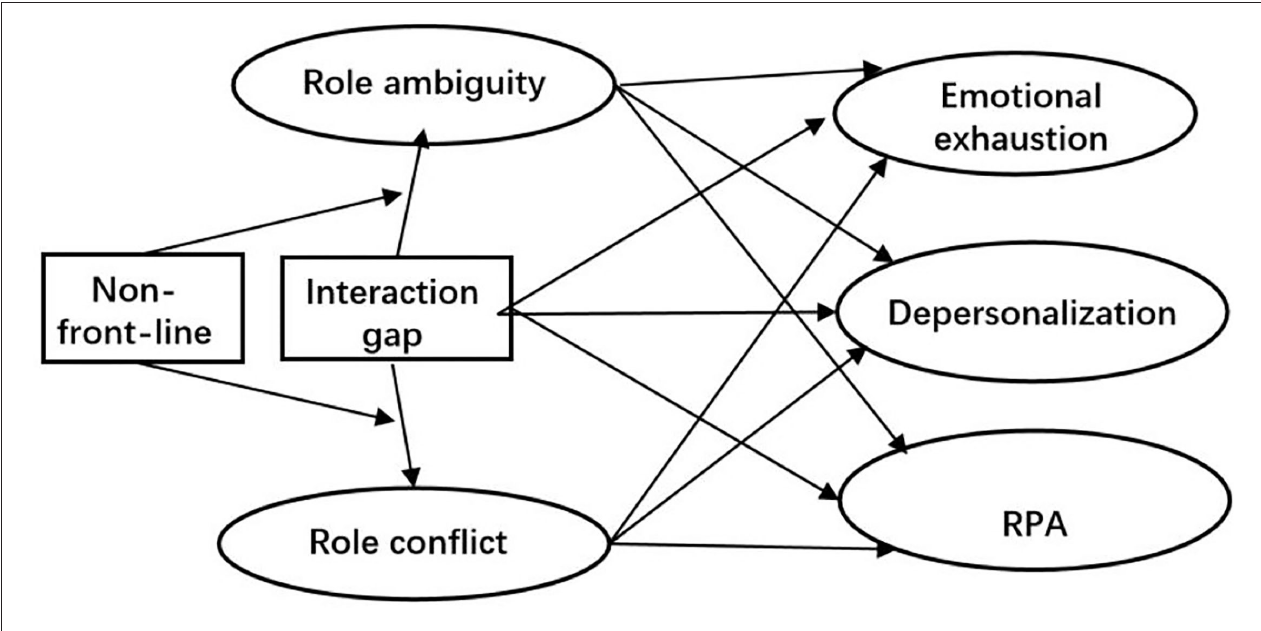
FIGURE 1 | Hypothesized